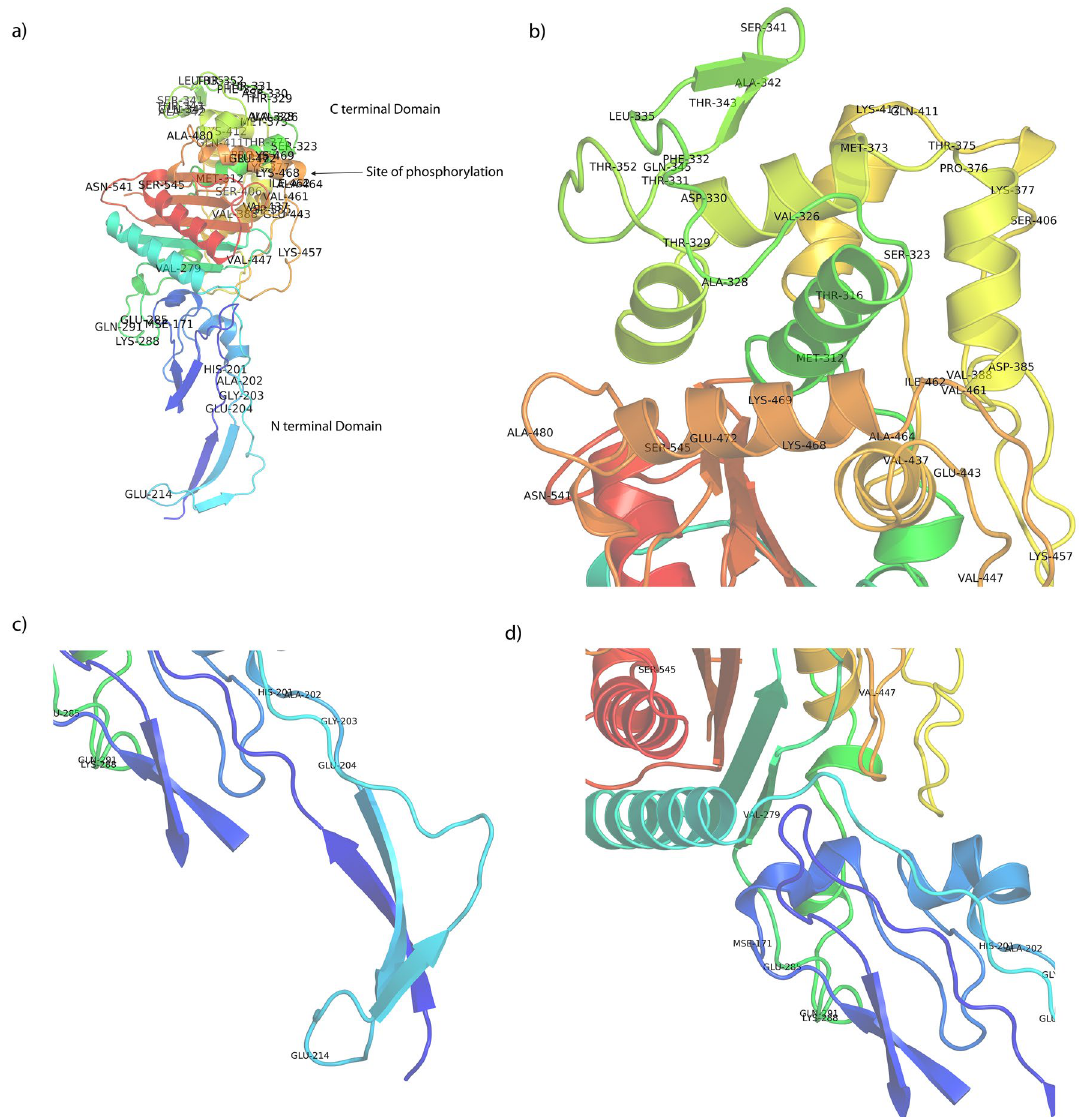
Figure 2. The structure of mosaic XXXIV PBP2 variant of N. gonorrhoeae clinical isolate ( a ) showing the location of important mutations and the active site sequence motifs, enlarge of ( b ) C terminal domain ( c ) N terminal domain ( d ) Site of phosphorylation. Mutations were modeled by PyMOL [DeLano, 2002] (The PyMOL Molecular Graphics System, Version 1.2r3pre, Schrödinger,